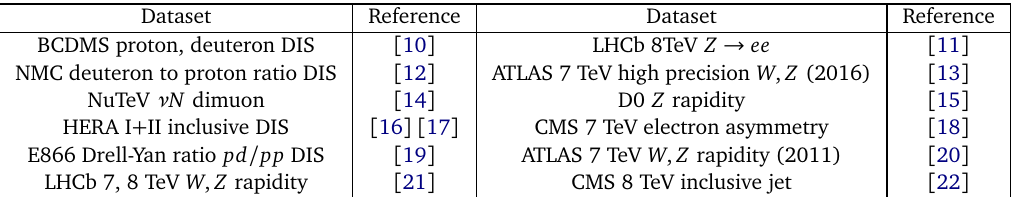
Table 1: Datasets included in the initial baseline reduced